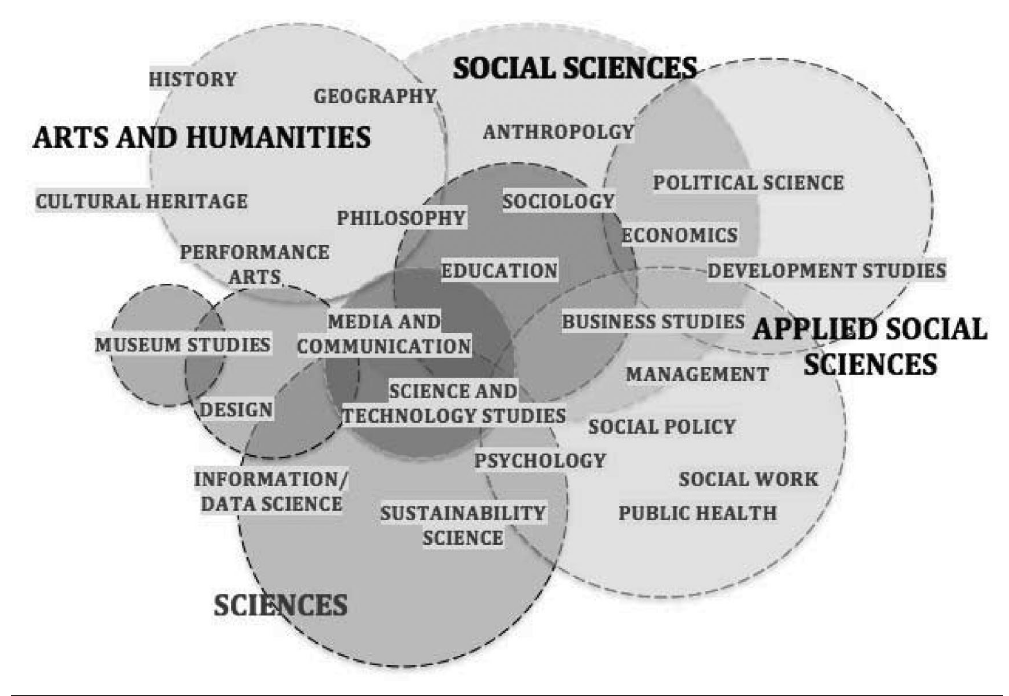
Figure 1: First iteration of the (inter)disciplinary/(cross)sectoral research landscape